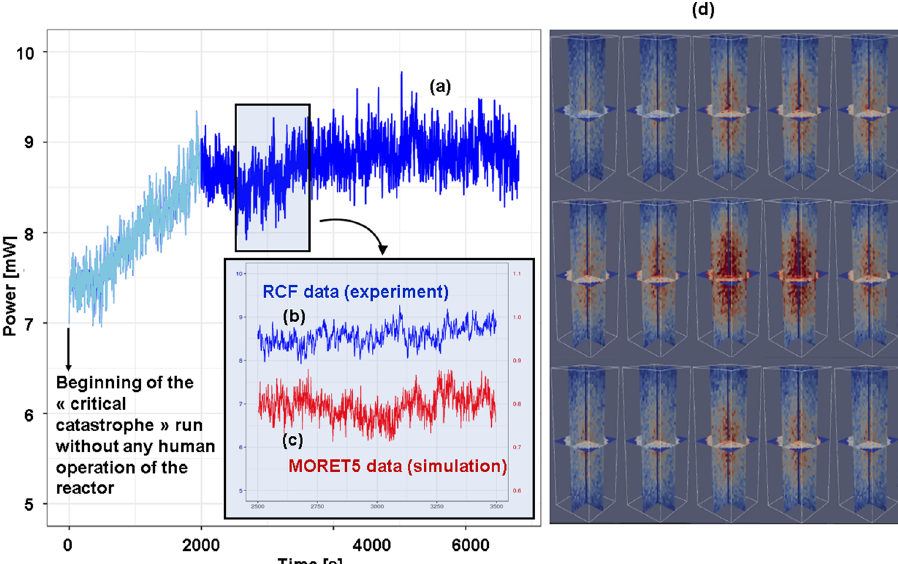
Fig. 3 “ Critical catastrophe ” experiment. a “ Critical catastrophe ” run at 9 mW during the Reactor Critical Facility (RCF) experiments (blue), with a zoom on the beginning of its stationary part ( b ) compared to MORET6 simulated data (red) at 0.8 mW ( c ). The time-gate width used by the of fl ine analysis was set to 1 ms. After a transient period (light blue) where the system reaches equilibrium, both experimental and numerical signals stabilize as well as their fl uctuations. While the power levels of the RCF data signal and the MORET6 simulated data are different, the stochastic neutron noises (variance-to-mean) are approximately the same, as foreseen by the stochastic modeling taking into account spontaneous fi ssions and delayed neutrons. The “ critical catastrophe ” predicted by Williams 1 is prevented by the mechanism described in Eq. (4): the fl uctuations are contained by the under-critical behavior of the core related to spontaneous fi ssion sources. d Numerical simulation of the power fl uctuations, using a fully “ analog ” simulation of the entire setup operated at 1.2 mW (reactor equipped with detectors and simulated with realistic statistics of neutrons). These simulations have been performed during 10 4 processors.day on Intel ® Xeon ® E5-2680 cores. Whenever analyzed with 1 ms time gate, the core exhibits a “ blinking power ” behavior, as also shown in Supplementary Video